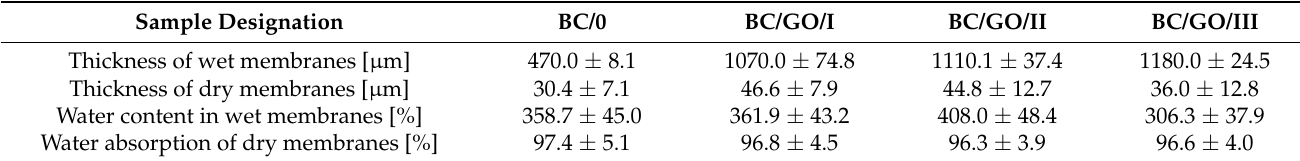
Table 2. Summary of the results of thickness and water absorption measurements for wet and dry